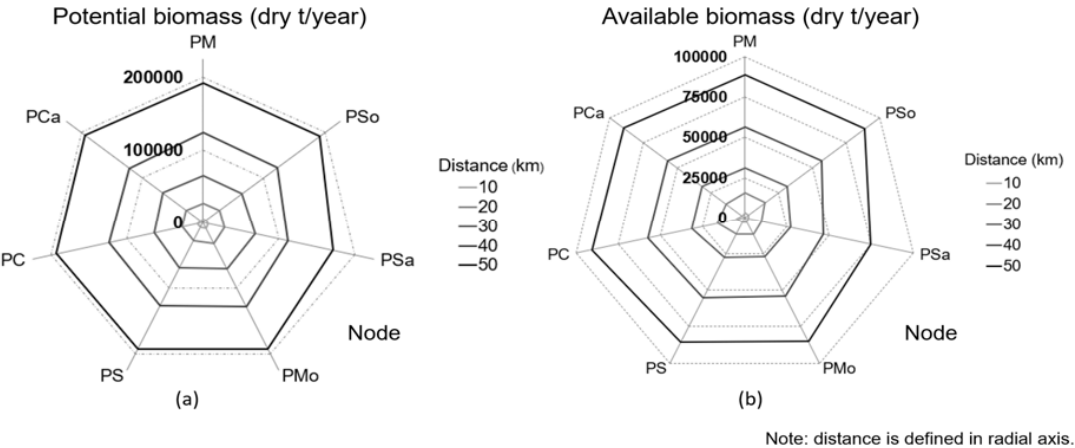
Figure 3. Mass per candidate node in the study area: ( a ) potential biomass (M) and ( b ) available biomass (m).